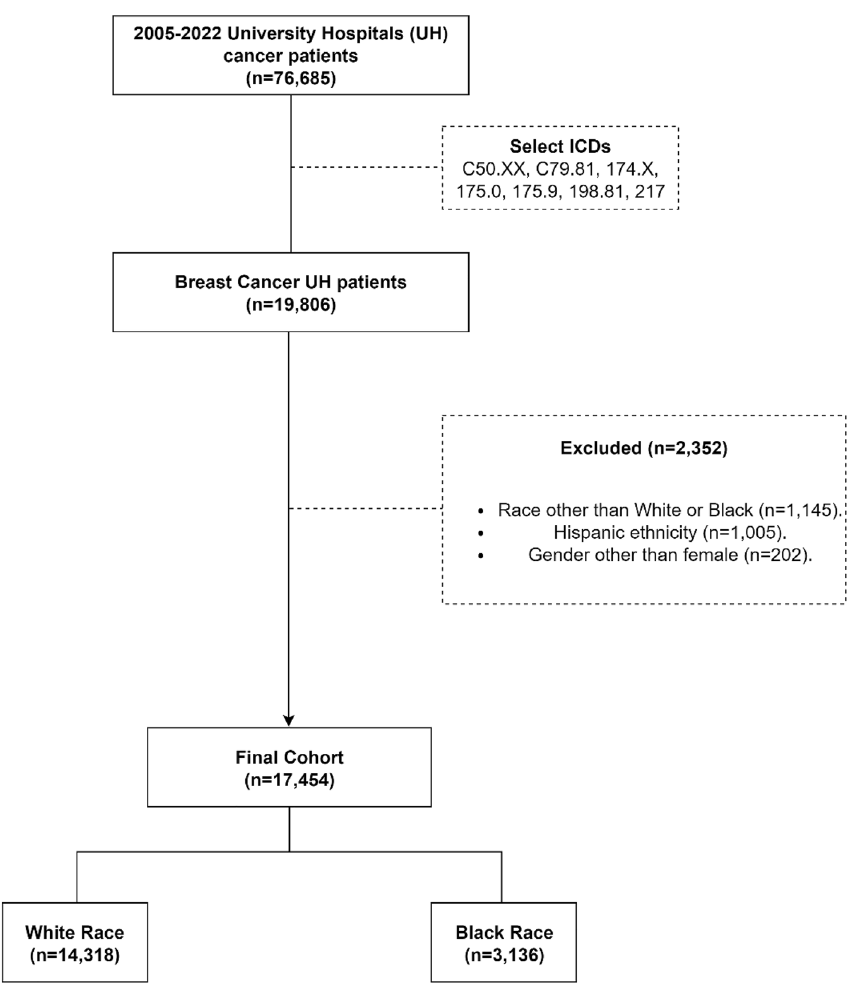
Figure 1. Study consort diagram detailing inclusion and exclusion criteria for Breast Cancer University Hospitals (UH) population (2005–2022). The final cohort included 17,454 patients, of which 3136 (18%) self- reported as